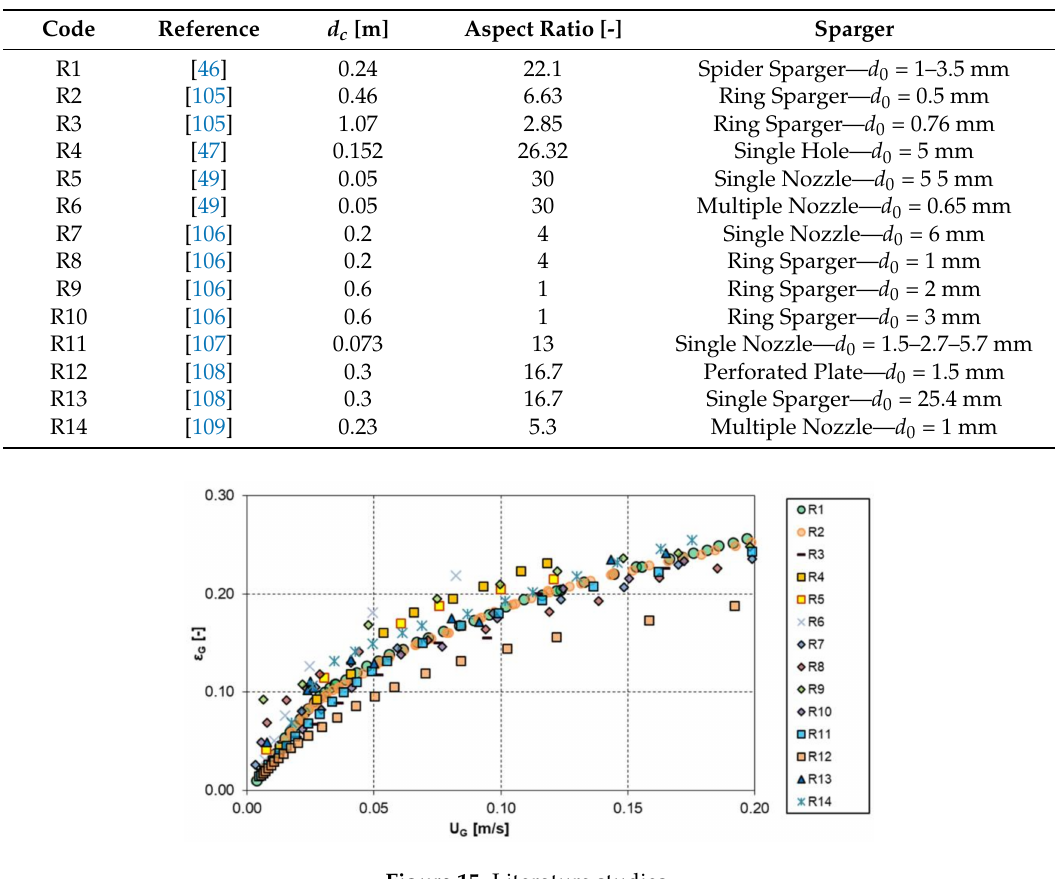
Figure 15. Literature studies. Table 2. Literature studies (reference codes for Figure